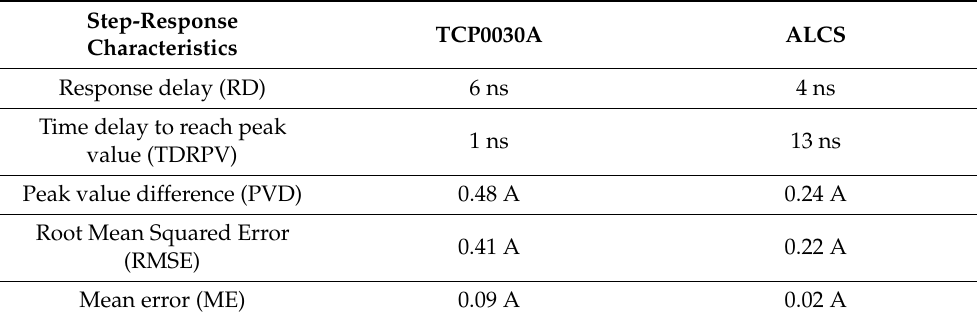
Figure 9. Current (A), Error (A), and Squared Error (A 2 ) in the function of time (ns)—analysis of the proposed sensor, ALCS, in comparison with CSR and TCP0030A probe. Table 3. Comparison of the current shunt resistor response with TCP0030A and ALCS (based on Figure 9)—CSR has been considered as a